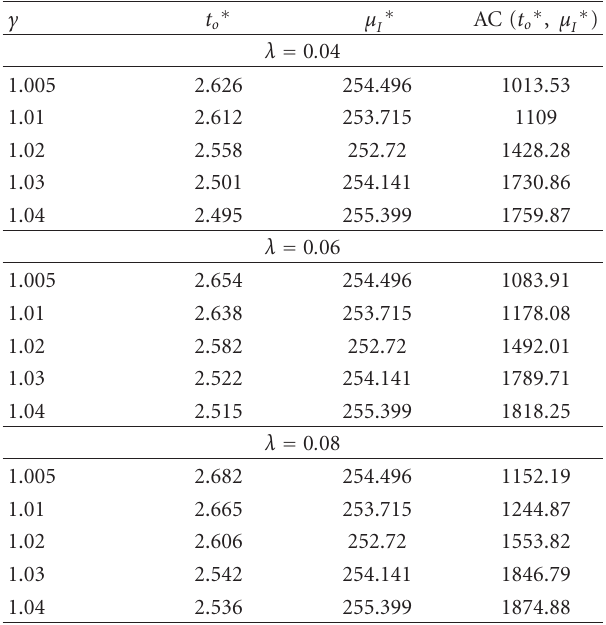
Table 1: Dependent of the optimal policy ( t ∗ λ and γ